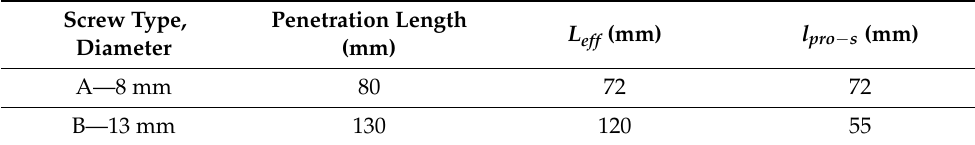
Table 6. Self-tapping screw